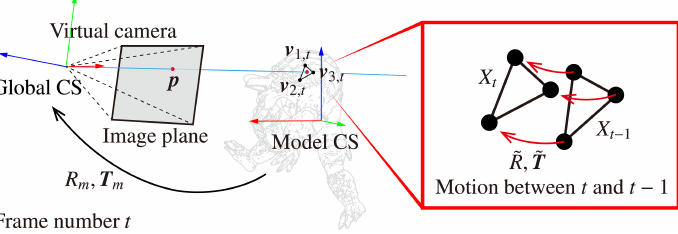
Figure 5. Derivation of the ground truth of motion and